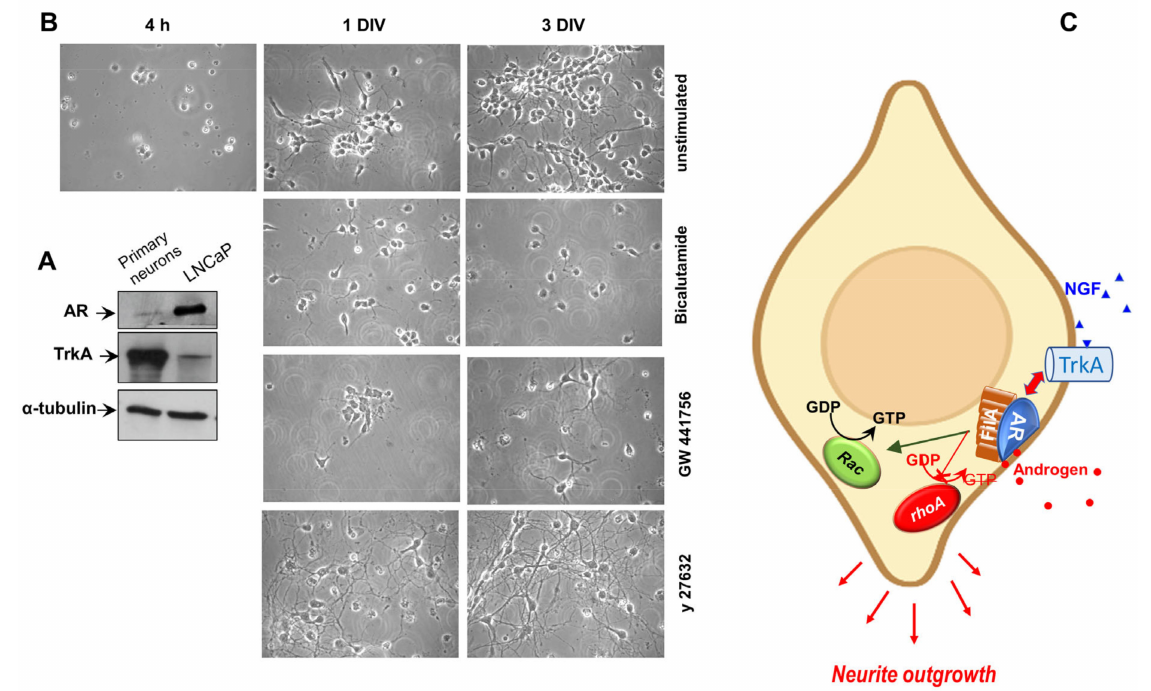
Figure 4. The role of AR, TRKa and ROCK in neuritogenesis. ( A ), Lysates proteins prepared from the indicated cell lines were analyzed by WB, using the antibodies against the indicated